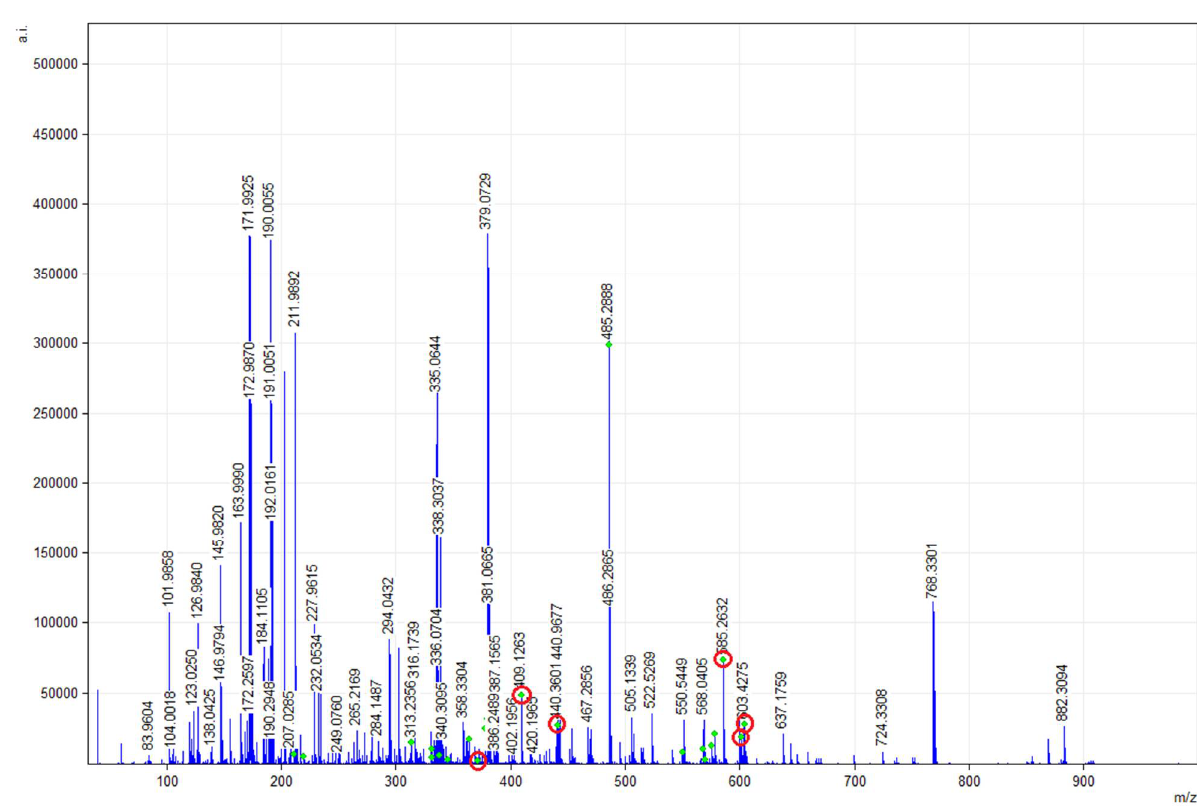
Figure 4. MALDI-TOF mMass report spectrum of glycerolipid (GL) profile of Extraction 3 (120 min). Spectra obtained between 100 and 900 m / z ratio signals from a sample of sAG mixed with the CHCA1 matrix. Those m / z ratio signals marked in blue correspond to MG and DG including EPA/DHA at the sn -2 position, as well as other MG/DG sAG. Database: LIPID MAPS for glycerolipids.